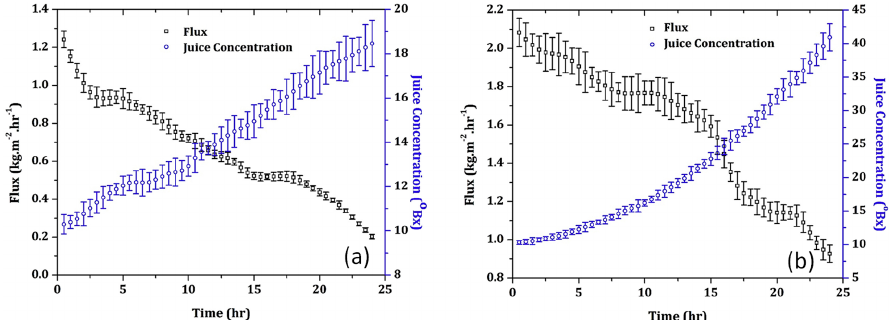
Figure 5. Concentration of clarified pomegranate juice with flat-sheet ( a ) PVDF and ( b ) PTFE membranes (Temperature, 25 ± 0.50 °C, feed and stripping solutions flow rate, 0.012 m 3 h − 1 , stripper (Temperature, 25 ± 0.50 ◦ C, feed and stripping solutions flow rate, 0.012 m 3 h − 1 , stripper concentration: concentration: 6 M) [105]. 6 M)